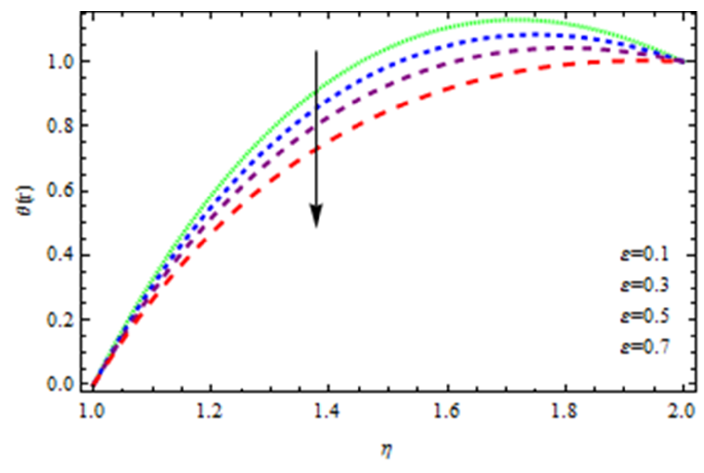
Figure 12. Influence of ϵ on the temperature curve.